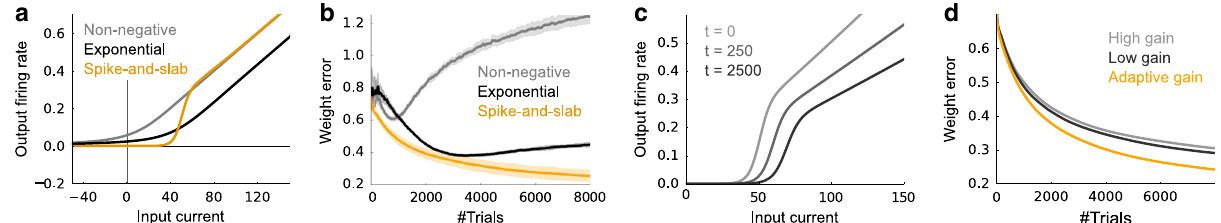
Fig. 5 Adaptive transfer functions. a The shapes of the transfer functions of granule cells under different priors on the odor distribution. See subsection “ Models with various priors on odor concentration ” in the Methods section for the details. b Weight errors under different priors. Shaded regions represent standard deviation over 10 simulations. c The average transfer function F ½ y ; c ¼ 0 (cid:4) at the beginning (light gray), middle (gray), and the end (black) of the learning. The x -axis represents the input current y . d The weight error under fi xed input gain, compared to the control model with adaptive gain, averaged over 50 simulations. For the gray line, the transfer function was set to the top curve in panel c ; for the black line it was set to the bottom curve. In all panels, M = 100 odors, N = 400 glomeruli, and three odors were presented on average.